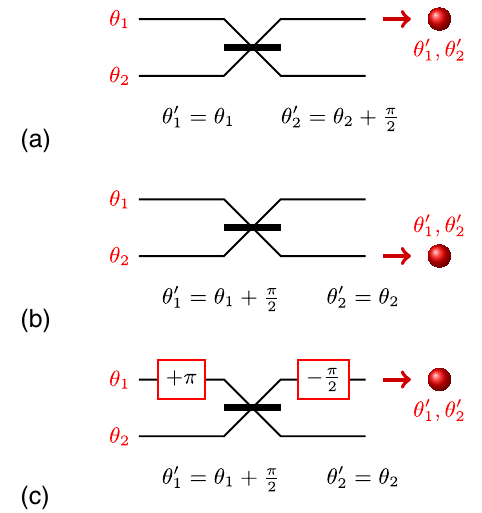
FIG. 9. (a) A photon detected at the upper output port of a beam splitter acquires a total phase θ 0 1 ¼ θ 1 if it has entered the beam splitter from the upper input port carrying a phase θ 1 , or a phase θ 0 θ 1 if it has entered the beam splitter from the lower input 1 ¼ port carrying a phase θ 2 . (b) Symmetric considerations can be made for a photon detected at the lower output port. (c) Suitable phase shifters can be added, to make the phases acquired by a photon detected on the upper output port equal to the ones that would have been acquired if detection occurred on the lower output port, as in case